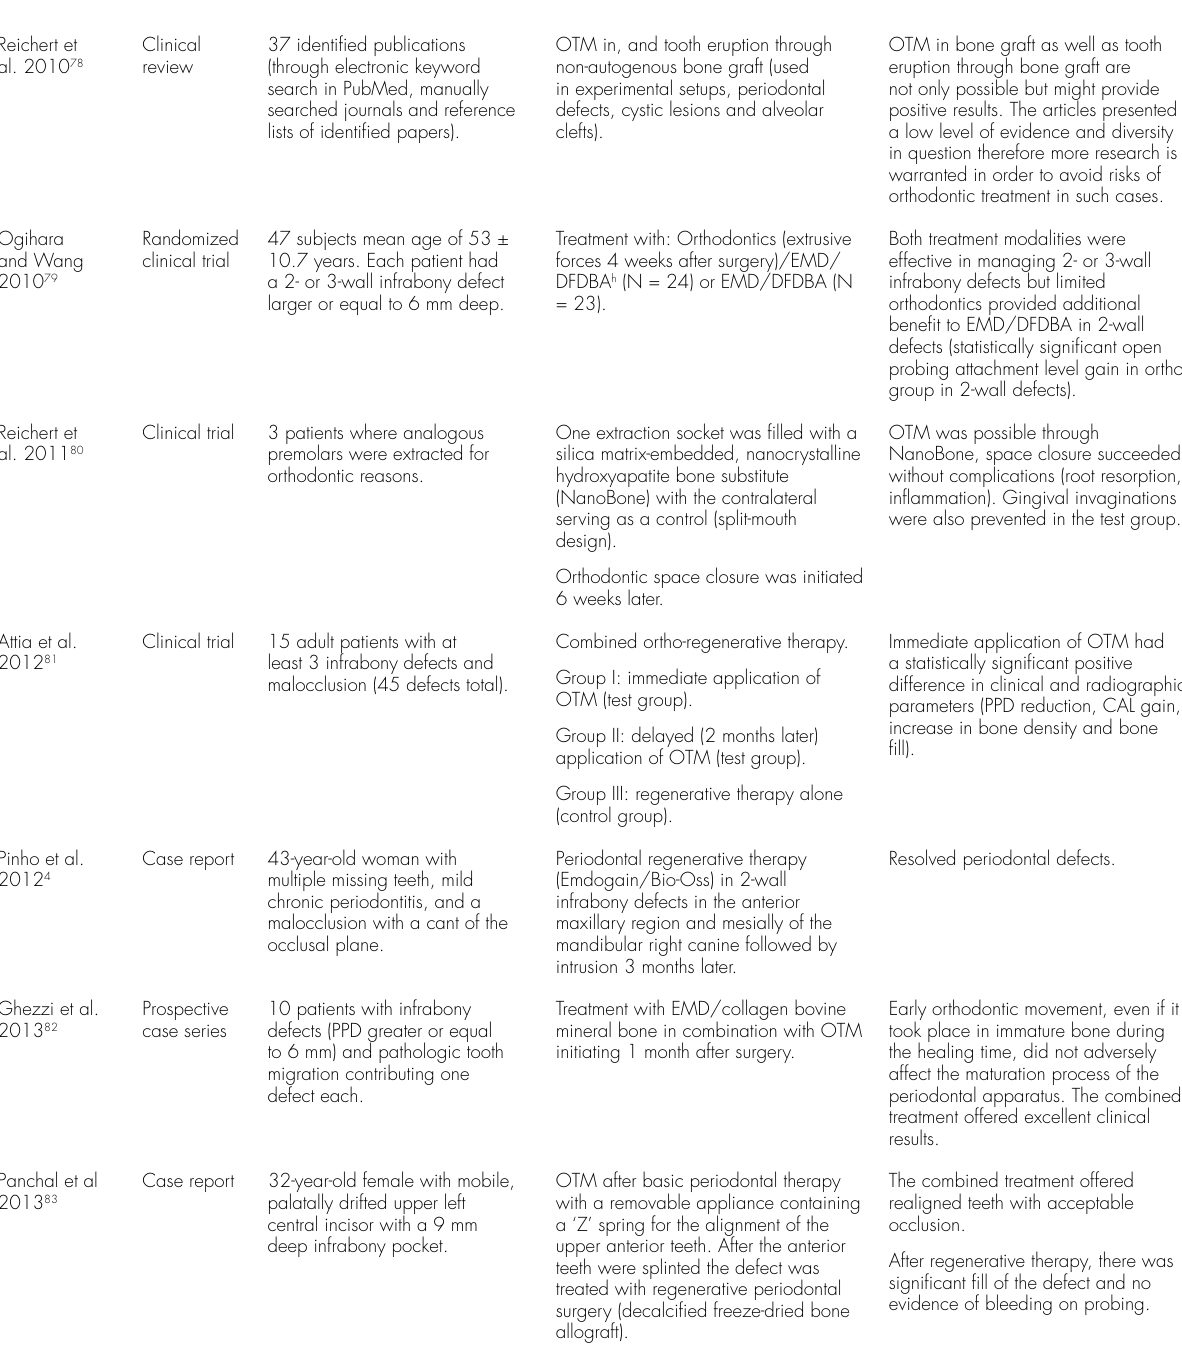
Table IIc. Orthodontic tooth movement in relation to angular bony defects treated with periodontal regenerative therapy: Systematic review studies subgroup.